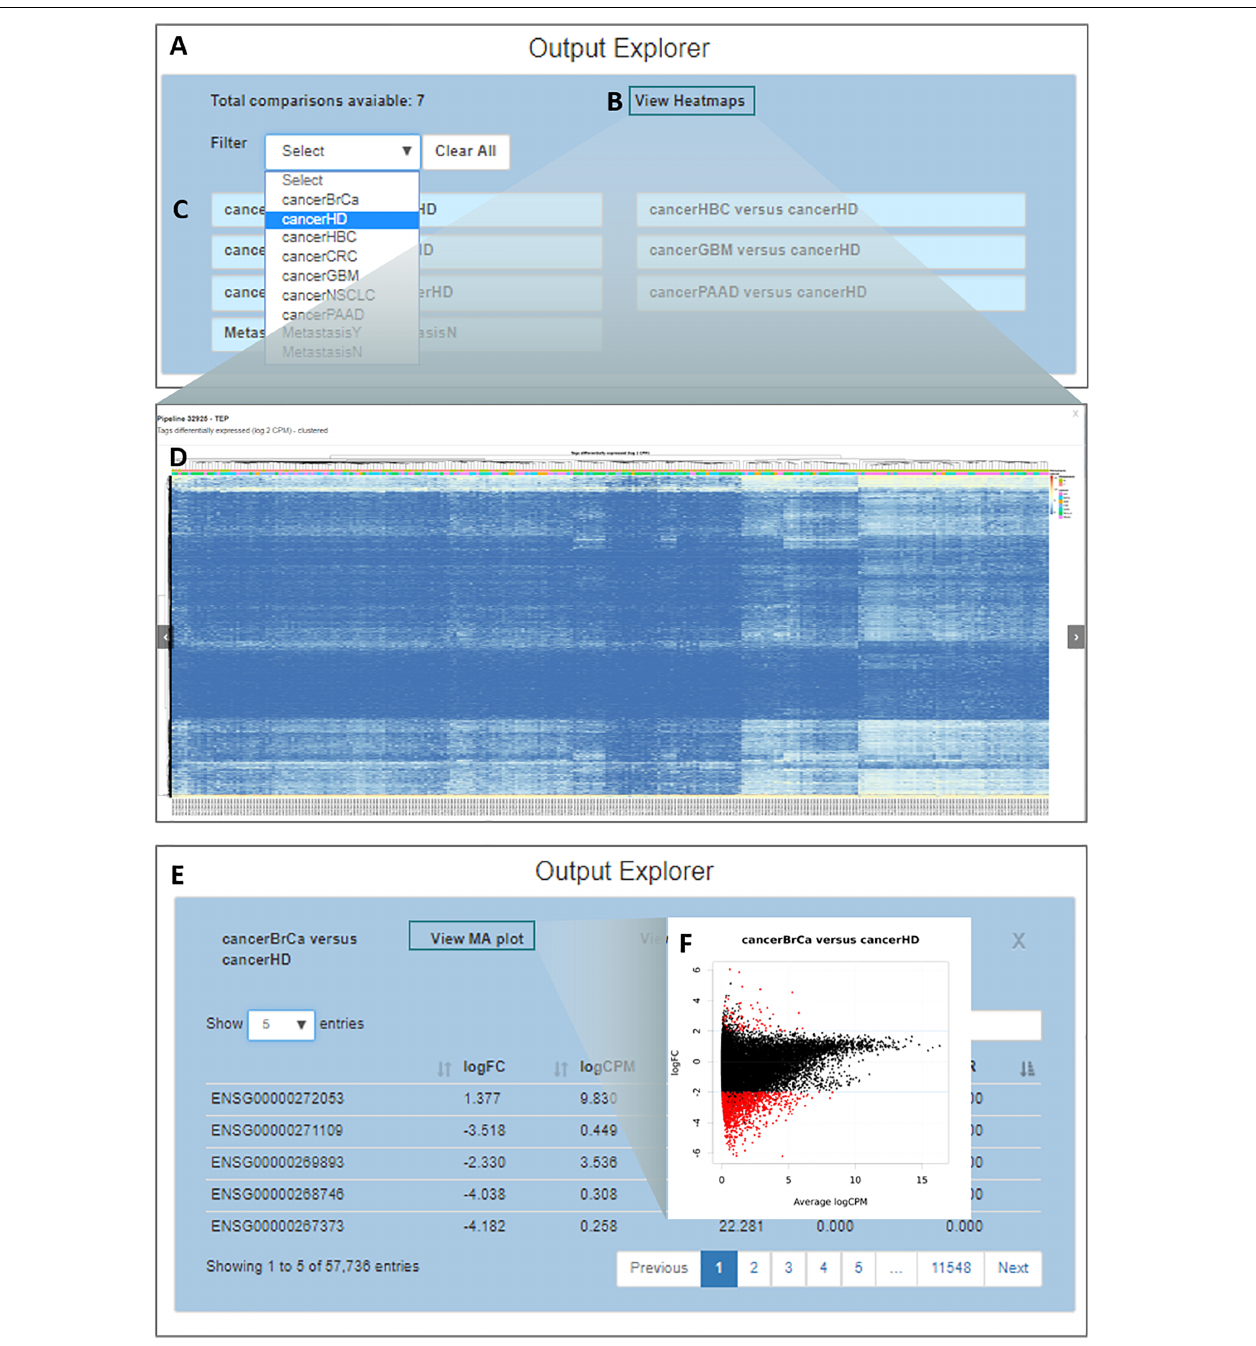
FIGURE 5 | Output explorer options. (A) The initial window where (B,D) heatmaps can be accessed and (C) listing all comparisons across variables. It is possible to filter the comparison list based on the variable category. (E) Results of a selected comparison (in this case BrCa vs. HD – breast cancer versus healthy donor). (F) An MA plot displaying the log (base 2) fold-change observed for the average log CPM of each group of interest (e.g., BrCa and HD), with genes differentially expressed highlighted in red.